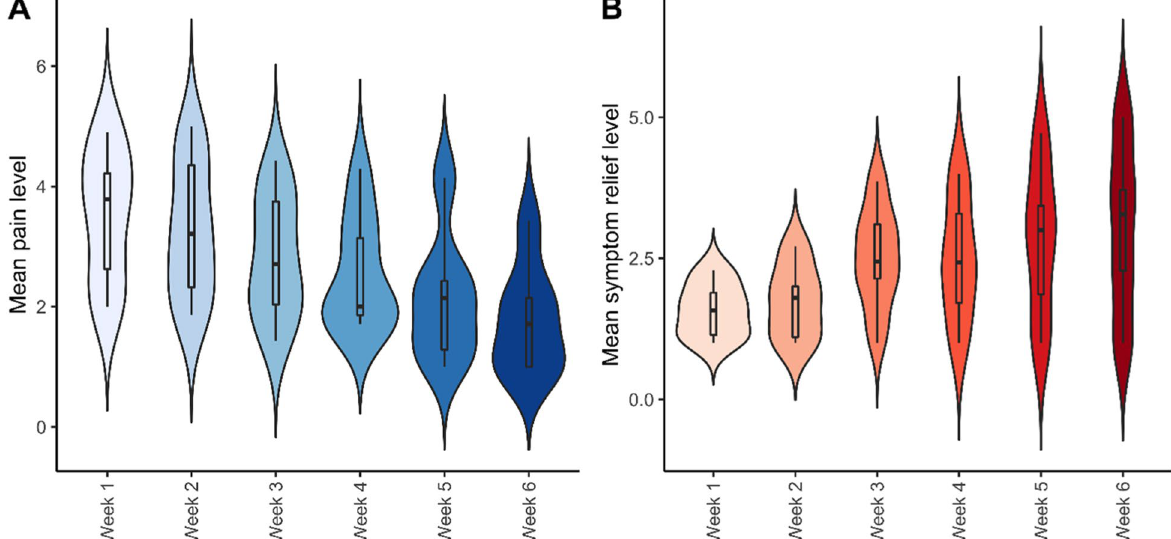
Fig. 4 Changes in pain level and symptom relief over the course of the cannabidiol treatment. Change in pain level and symptom relief as reported on a self-report pain journal. Subjects were asked to rank their pain each morning on a scale where 0 is equal to no pain and 5 is equal to the worst possible pain. They were also asked to record their symptom improvement on a scale where 1 is equal to no improvement and 5 is equal to complete improvement. Ordinate in A : mean score on the pain journal. Ordinate in B : mean symptom improvement as recorded in the pain journal. Abscissa for both: scores from week 1 to week 6. Error bars represent the standard error of the mean